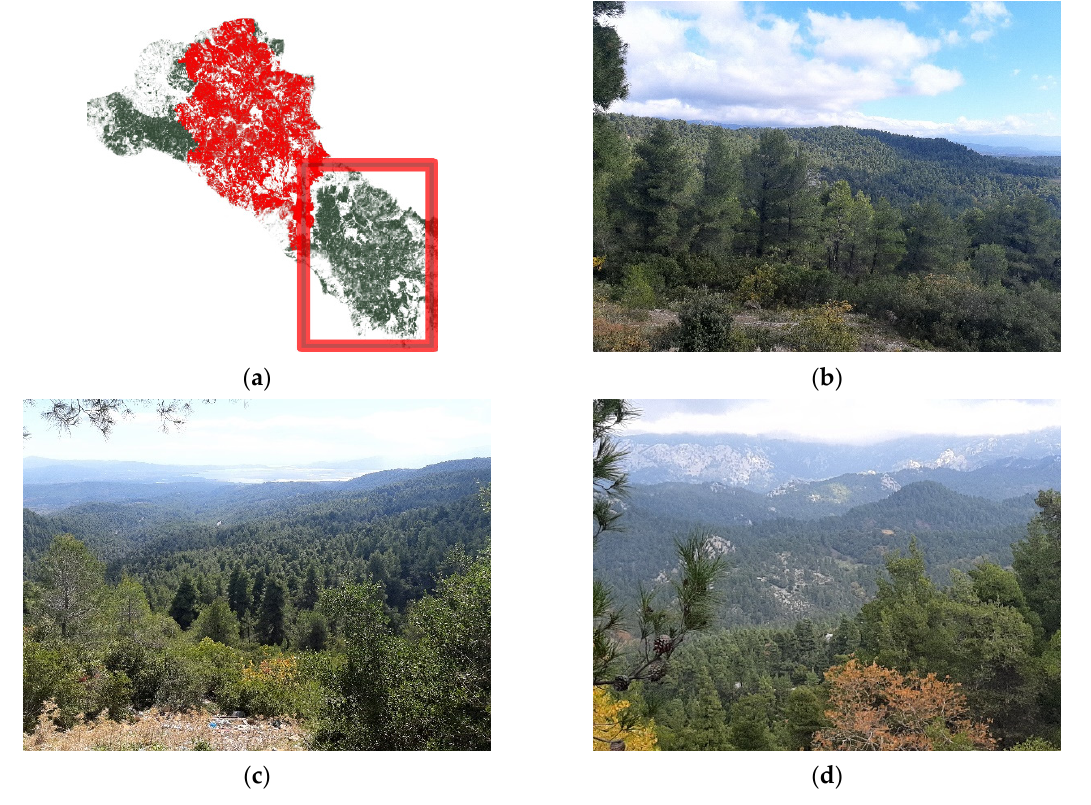
Figure 21. ( a ) Map of north Euboea. The burnt forest is presented in red, and the unburnt south part of Krya Vrisi is presented inside the red rectangle. ( b – d ) Photographs of the forest in the south part of Krya Vrisi.